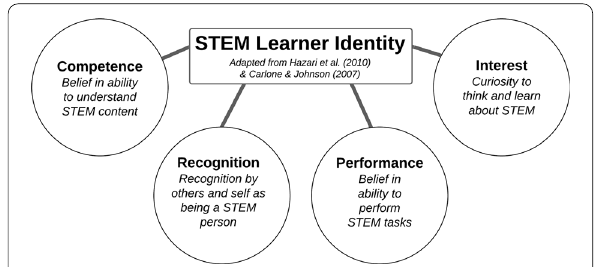
Fig. 2 Components of STEM learner identity (Carlone &